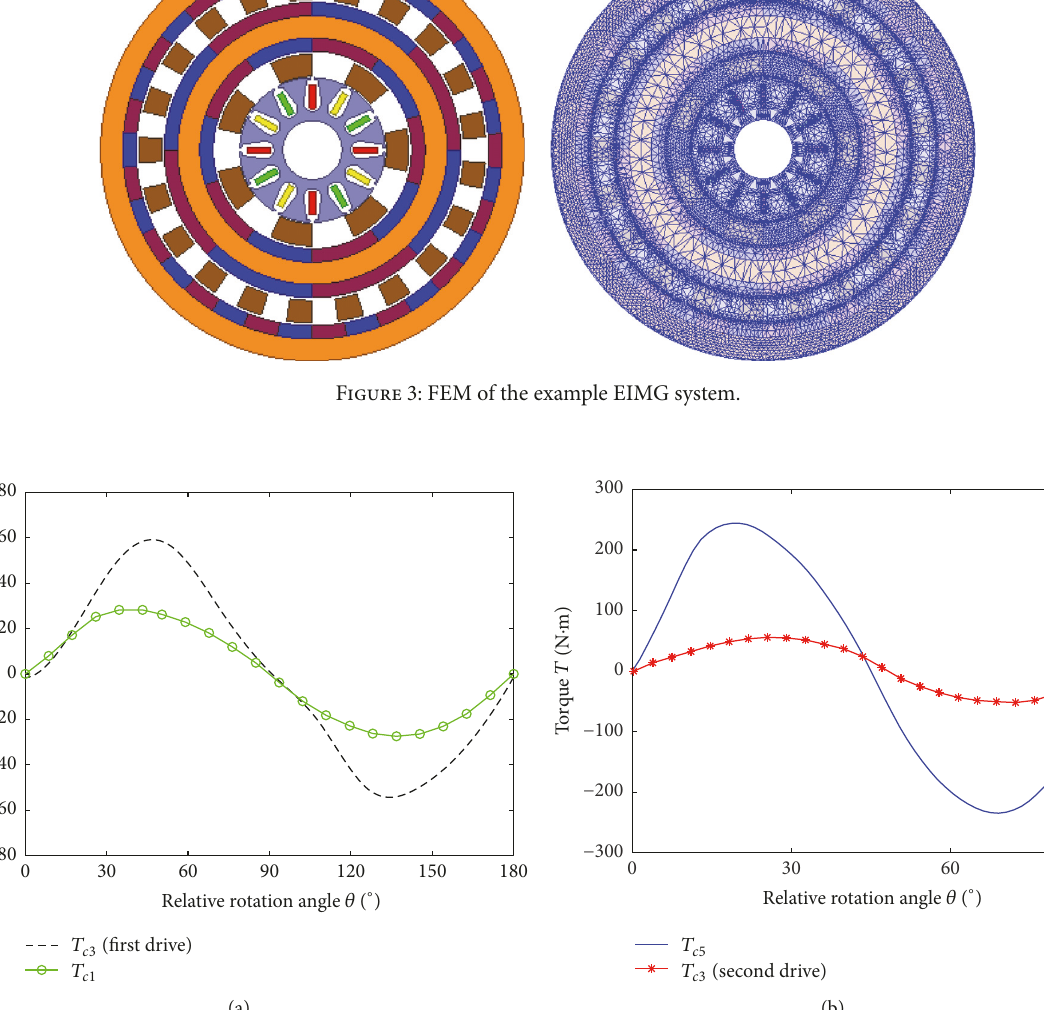
Figure 4: Torque profiles of the example EIMG system.